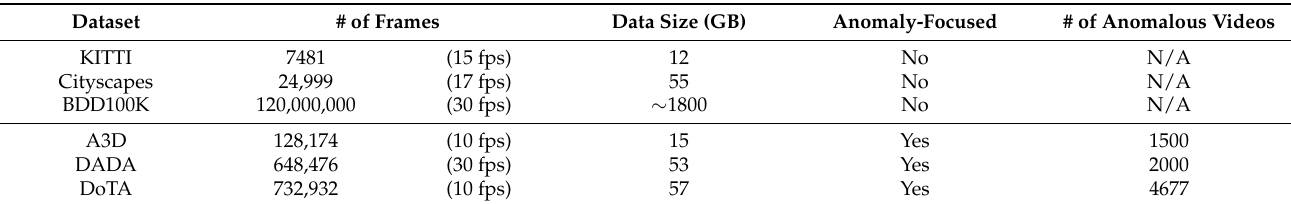
Table 2. High-quality driving video datasets. DoTA, Detection of Traffic